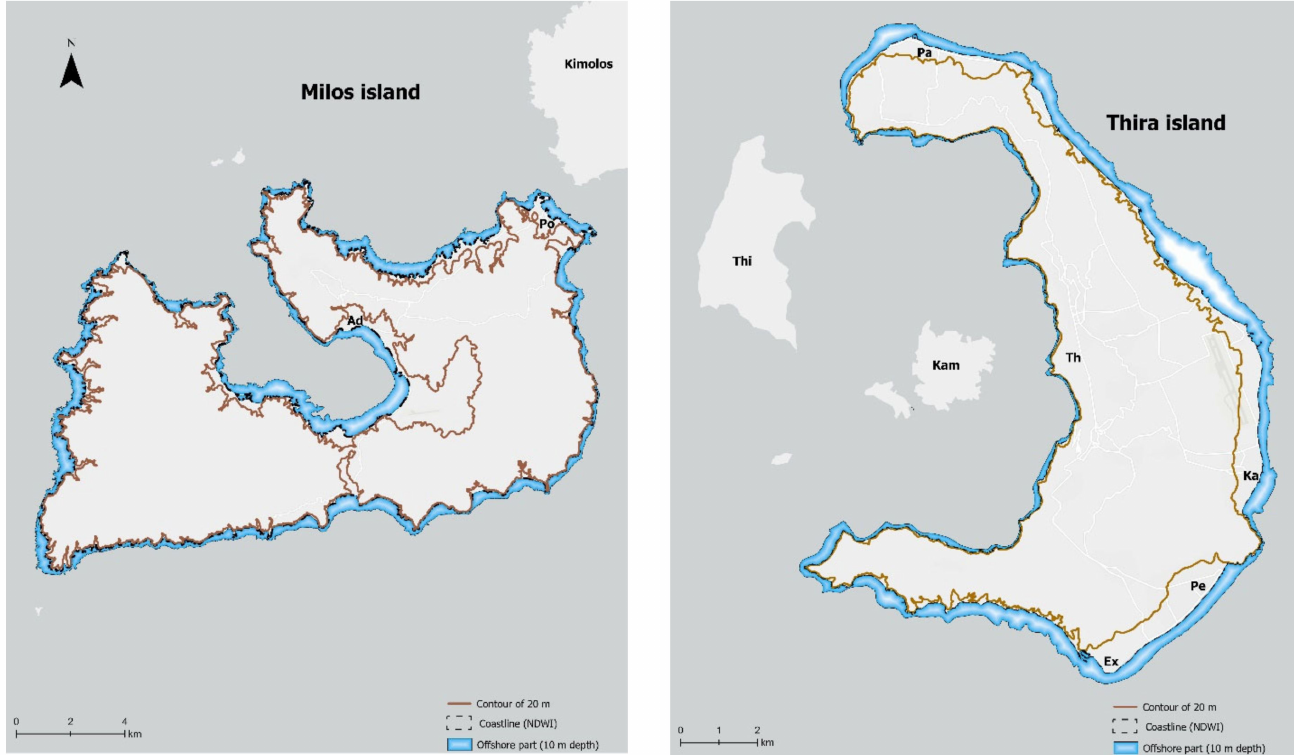
Figure 12. The coastal boundaries of Milos ( left ) and Thira ( right ) (Santorini complex) Islands regarding the elevation contour of 20 m (brown line) and the isobath of 10 m (blue polygon). Ad: Adamas, Po: Pollonia, Thi: Thirasia, Kam: Kamenes volcano islands, Ex: Exomitis, Pe: Perissa, Ka: